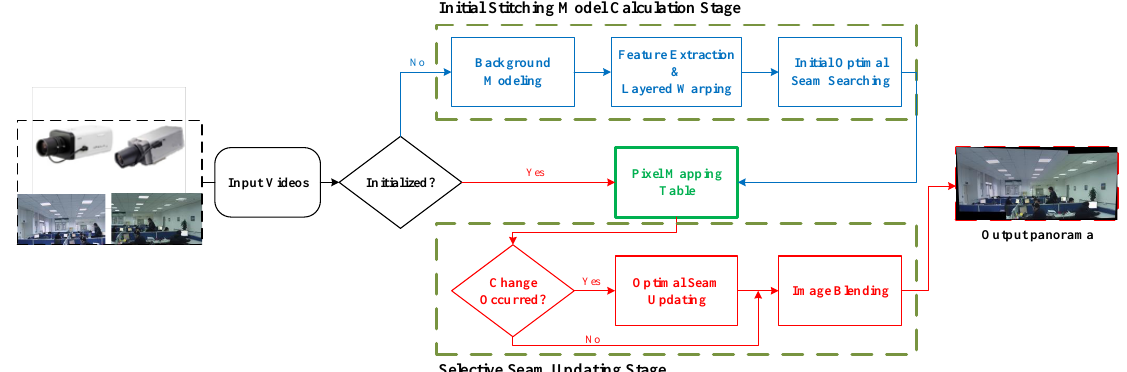
Figure 2. Outline of the proposed video stitching procedure. Our method consists of two stages: initial stitching model calculation stage and selective seam updating stage. In the initial stitching model calculation stage, we first use background modeling algorithm to generate still background of each input source video, then utilize layered warping algorithm to align background images, finally, we perform optimal seam searching and image blending to generate panorama